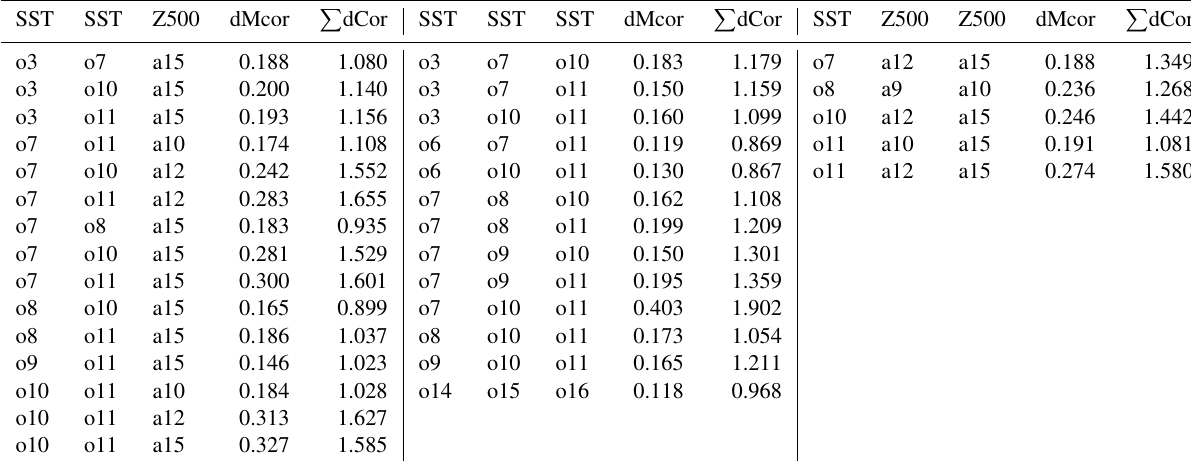
Table 2. Significant interaction strength between domain triples in CERA-20C over 1901–2010; dMcor: distance multicorrelation; (cid:80) dCor: sum of pairwise distance correlations.